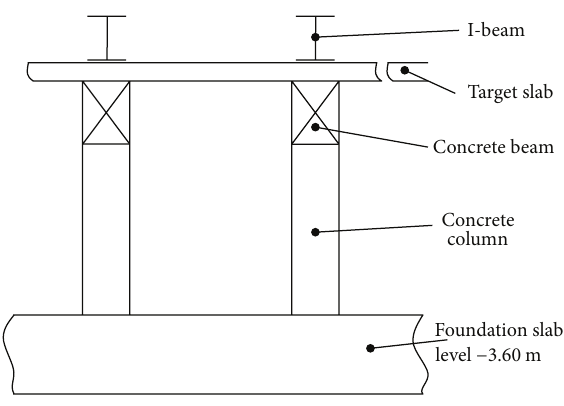
Figure 5: Cross-section of target slab bearing structures.